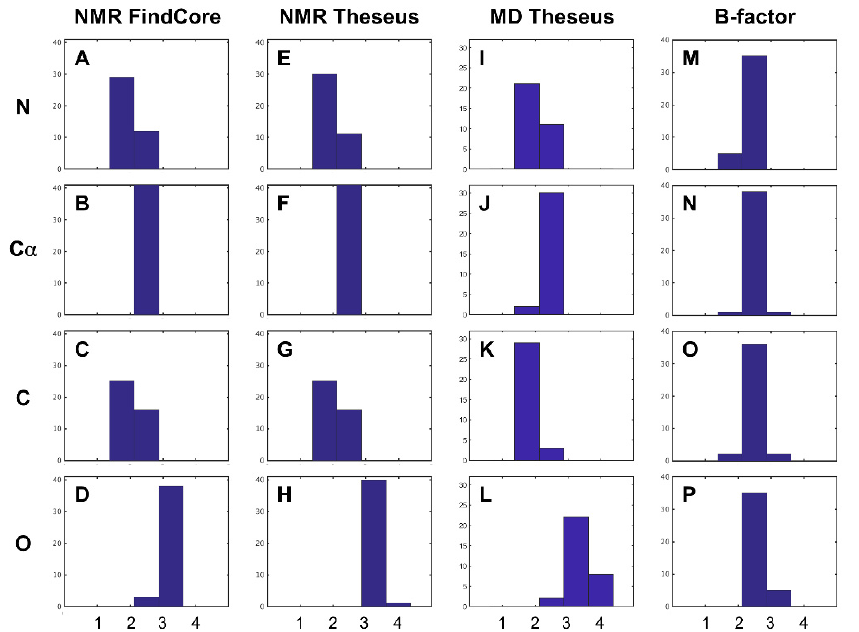
Figure 2. Distribution of average ranks of coordinate uncertainties, variances, and B-factors of backbone heavy atoms. As described in the main text, atoms in each residue are ranked by ( A – D ) coordinate uncertainty of FindCore superimposed NMR ensembles, ( E – H ) THESEUS superimposed NMR structures, coordinate variances of ( I – L ) THESEUS superimposed MD trajectories and ( M – P ) B-factors. For each structure, an average rank is calculated for each backbone heavy atom type: (first row) amide N, (second row) C α , (third row) carbonyl C, and (fourth row) carbonyl O. For superimposed NMR ensembles (columns one and two) and MD trajectories (column three), a clear pattern is visible: average ranks for amide nitrogen atoms and carbonyl carbon atoms are often lower than average ranks for C α atoms. The average ranks for carbonyl oxygen atoms are usually higher. When backbone heavy atoms are ranked by a B-factor, however, the average ranks for all backbone heavy atoms typically are between 2–3. The average ranks plotted in this figure are tabulated in Tables S2–S5, Supplementary